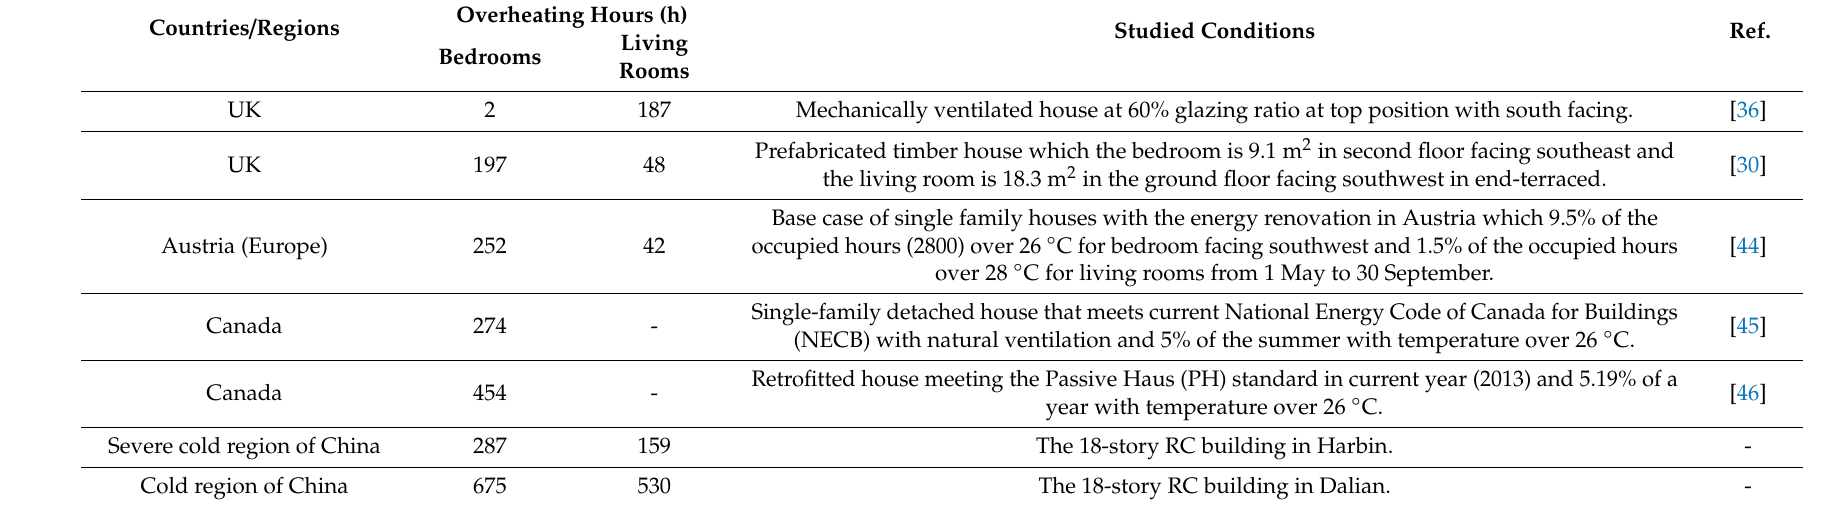
Table 12. Comparison of building overheating hours at the same latitude in the northern